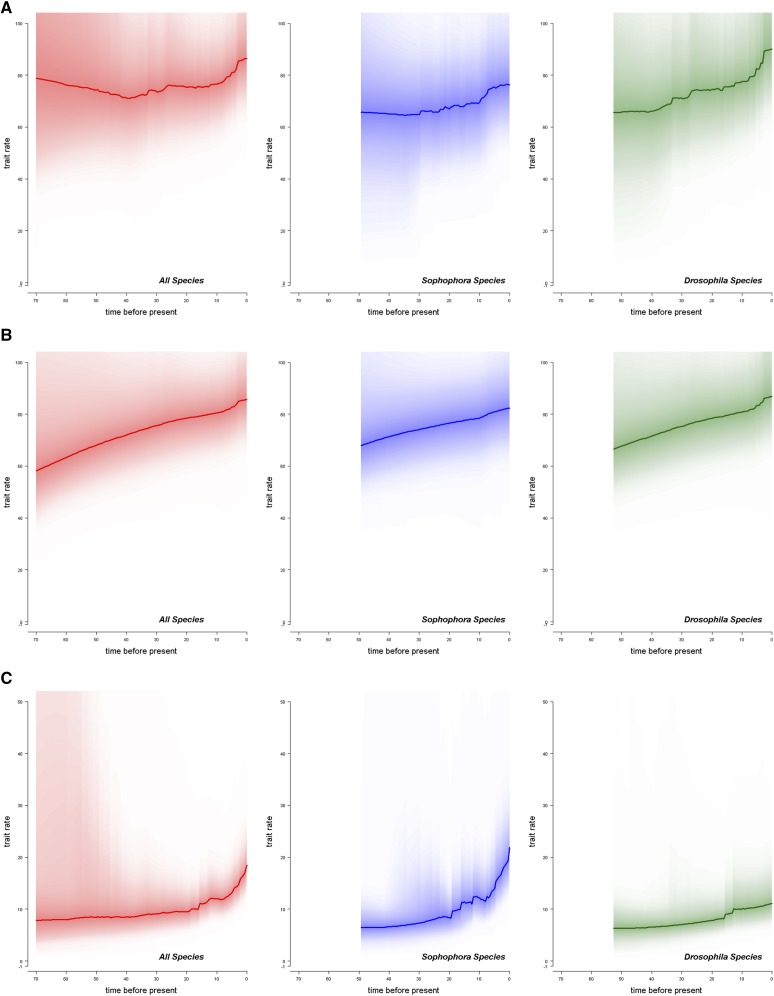
Rate of change in genome size and sex difference change through time. (A) The rate of female genome size change throughout time (B) The rate of male genome size change throughout time (C) The rate of sex difference change throughout time. The left panels (red) are for the entire Drosophila genus. The middle panels (blue) represent the Sophophora subgenus. The right panels (green), represent the Drosophila subgenus.